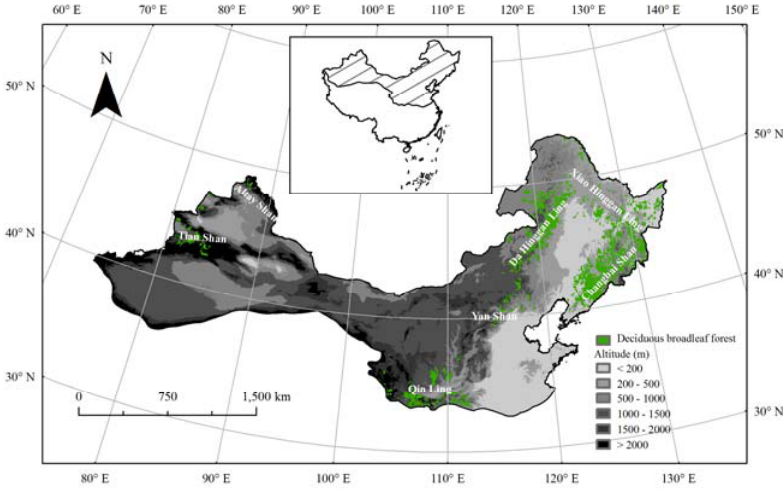
Figure 1. Distribution of the temperate deciduous broadleaf forest areas in northern